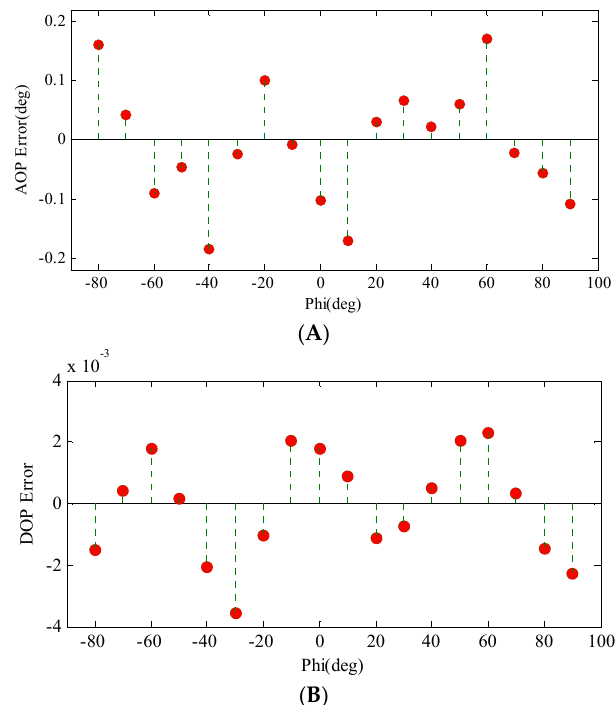
Figure 9. The measurement errors of AOP ( A ) and DOP ( B ). The AOP errors are relatively low and the DOP measurements are stable. The potential remaining sources of error may come from the random output noises of the circuit components, the analog to digital converter (ADC) errors and the unstable incident light.